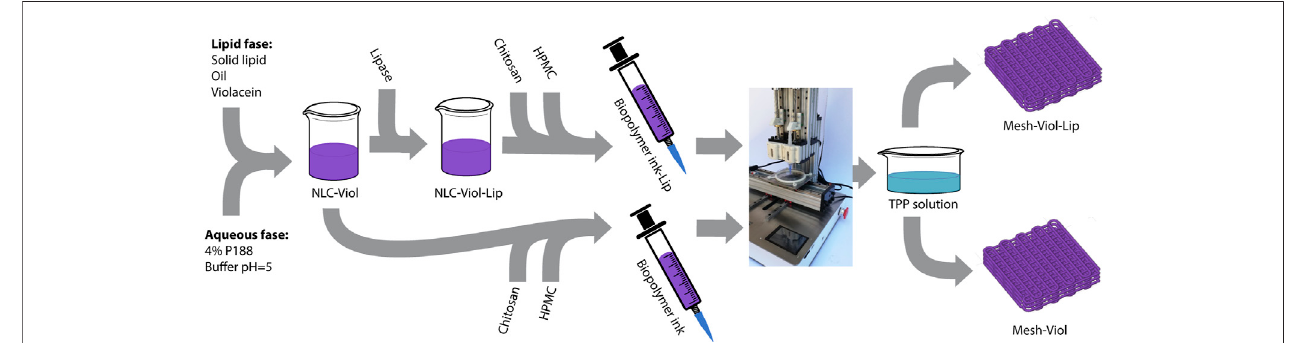
FIGURE 1 | Simpli fi ed work fl ow to produce the 3D